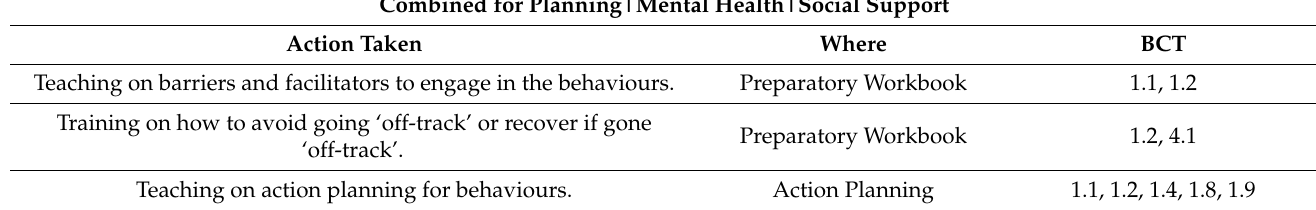
Table 2. Combined actions to be taken to support the barrier/facilitator themes of planning, mental health and social support, where in the intervention those actions will be taken and the BCT numbers (Table 3) that the action represents are based on Michie et al.’s taxonomy [17]. BCT ** is ‘increase positive emotions’, which is a new BCT scheduled for inclusion in future iterations of the